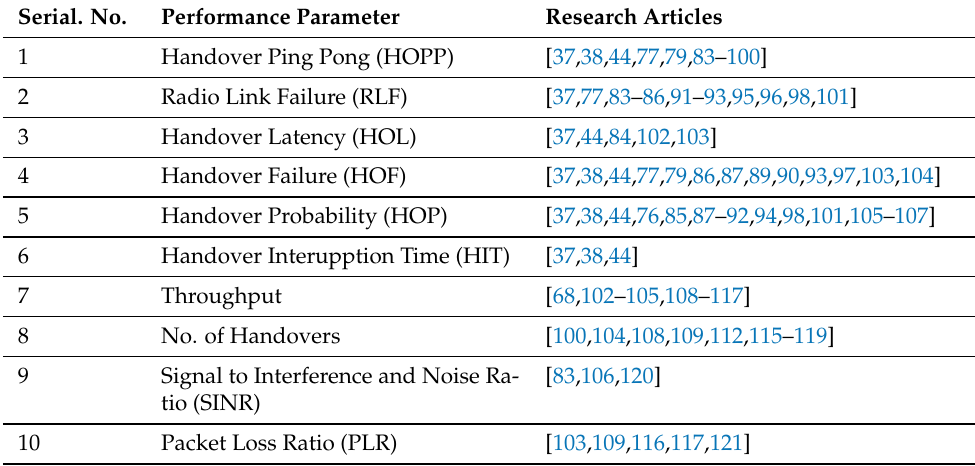
Table 3. Research Articles based on Performance Parameters. Serial. No.